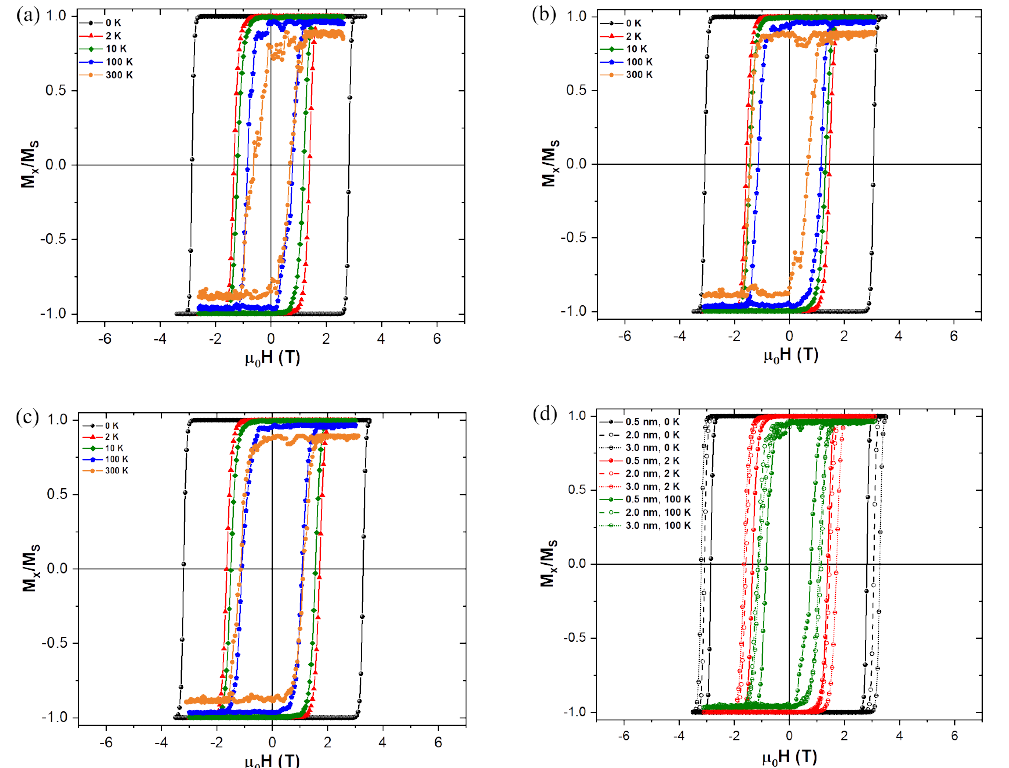
Figure 5. Coercivity changes due to both different simulated temperatures and different disordered shell thicknesses, of 0.5 nm ( a ), 2 nm ( b ) and 3 nm ( c ), whereas ( d ) directly compares the temperature effects for the different shell thicknesses. In general the thicker the shell, the larger the coercivity. As the temperature increases the thermal field effects become more important than the thickness ones, for the overall dynamics of the NP